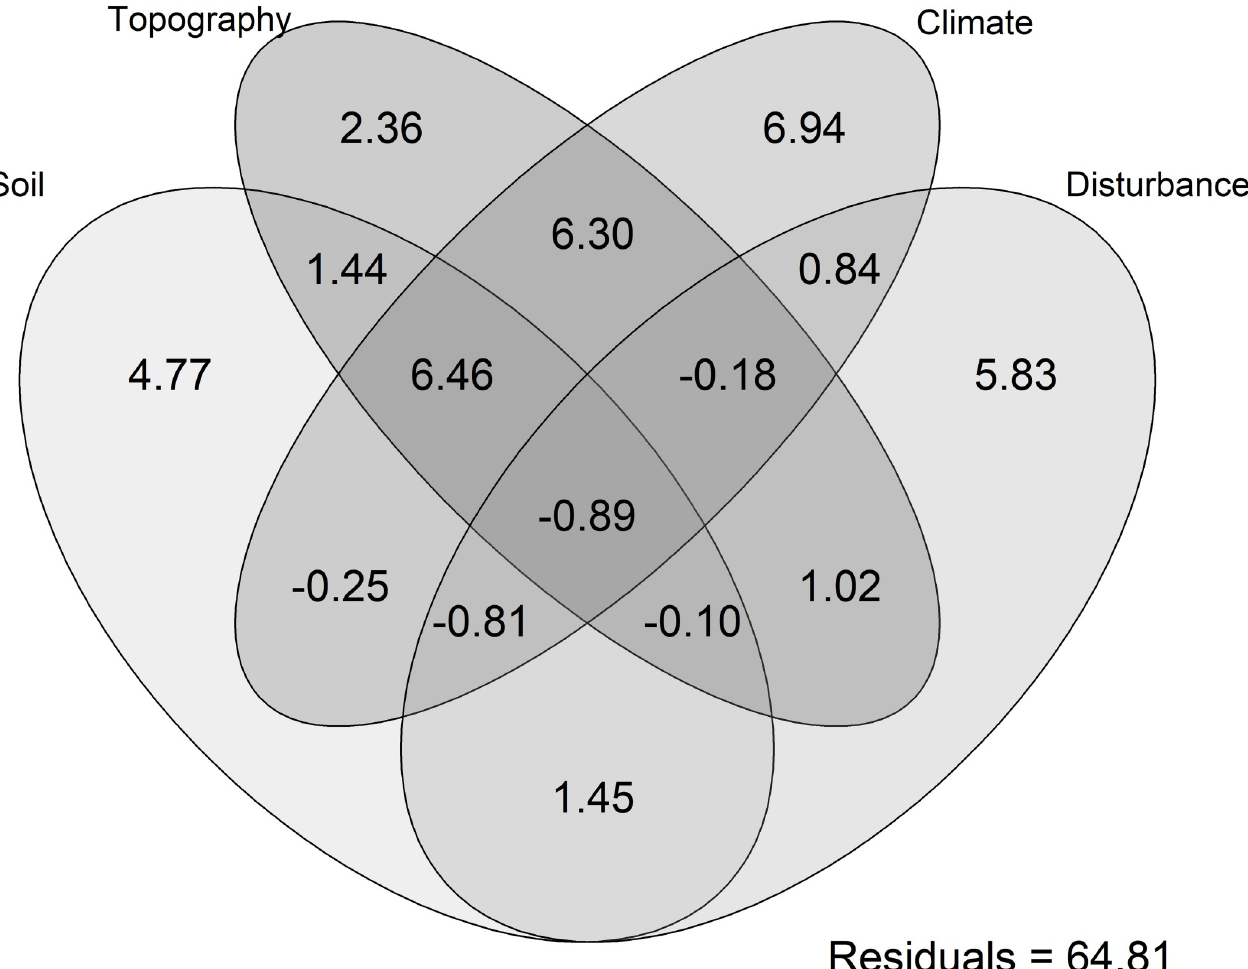
Fig 6. The Venn diagram showing variation partitioning results (partial CCA model) and the contribution of the four studied environmental and disturbance variable groups (i.e., climatic, soil, topography, and disturbance) that drive the plant species distribution. The proportion of variance in tree species composition explained by environmental and disturbance factors. The values represent adjusted R 2 (%) of independent and shared effects by 4 the factors.